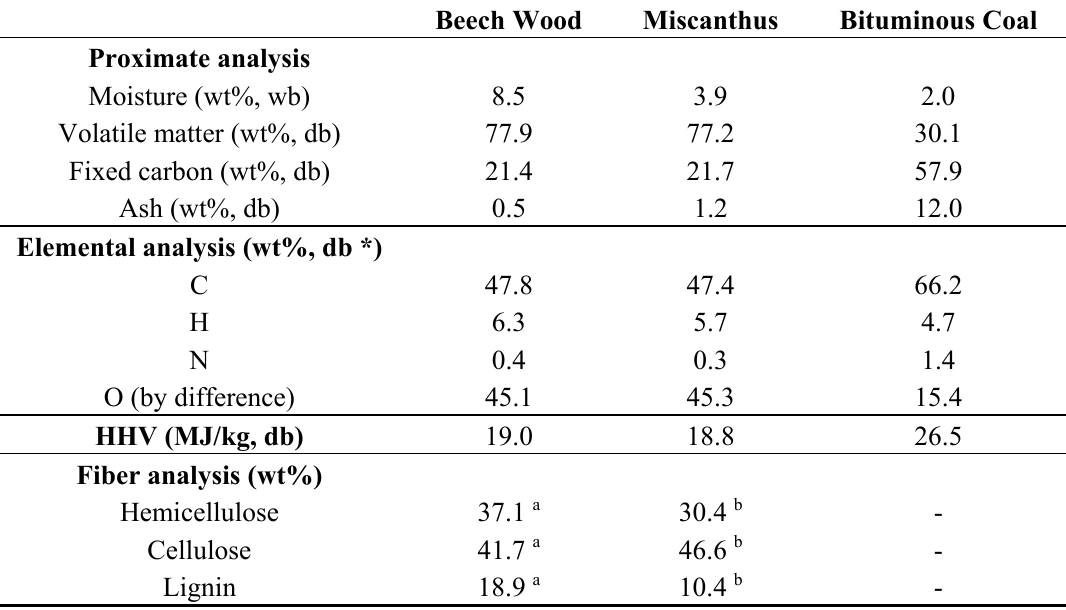
Table 1. Properties of beech wood and miscanthus. Beech Wood Miscanthus Bituminous